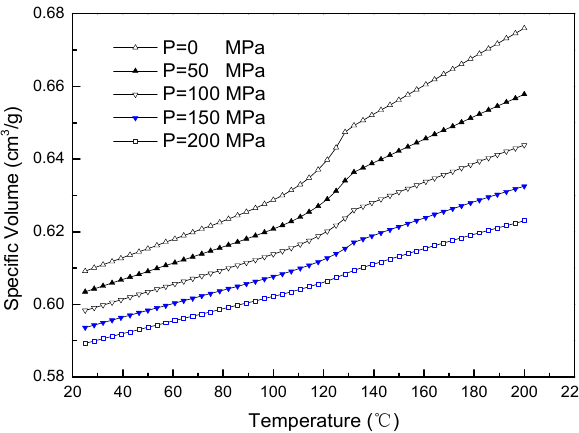
Figure 2. The PVT properties of polylactic acid (PLA).